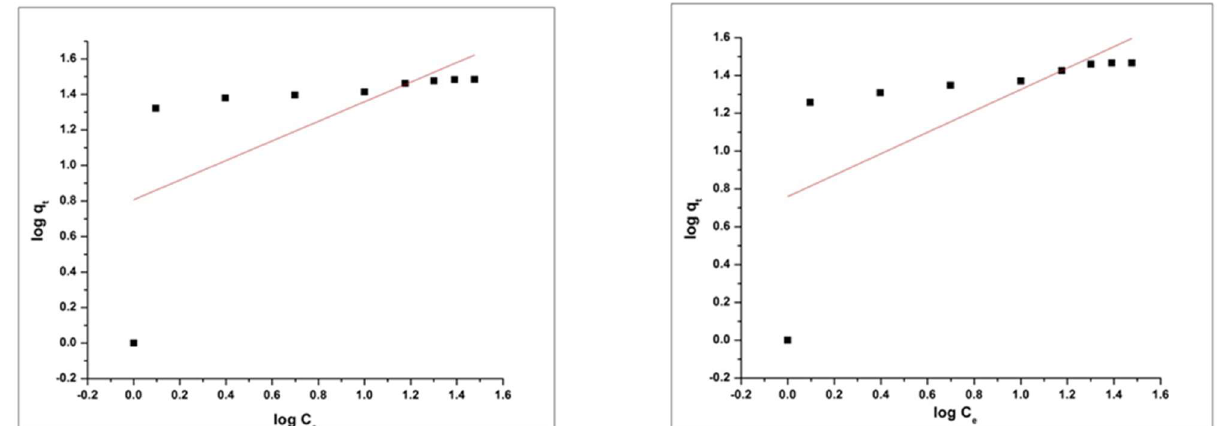
Figure 23. Freundlich adsorption isotherm of MO and RhB.